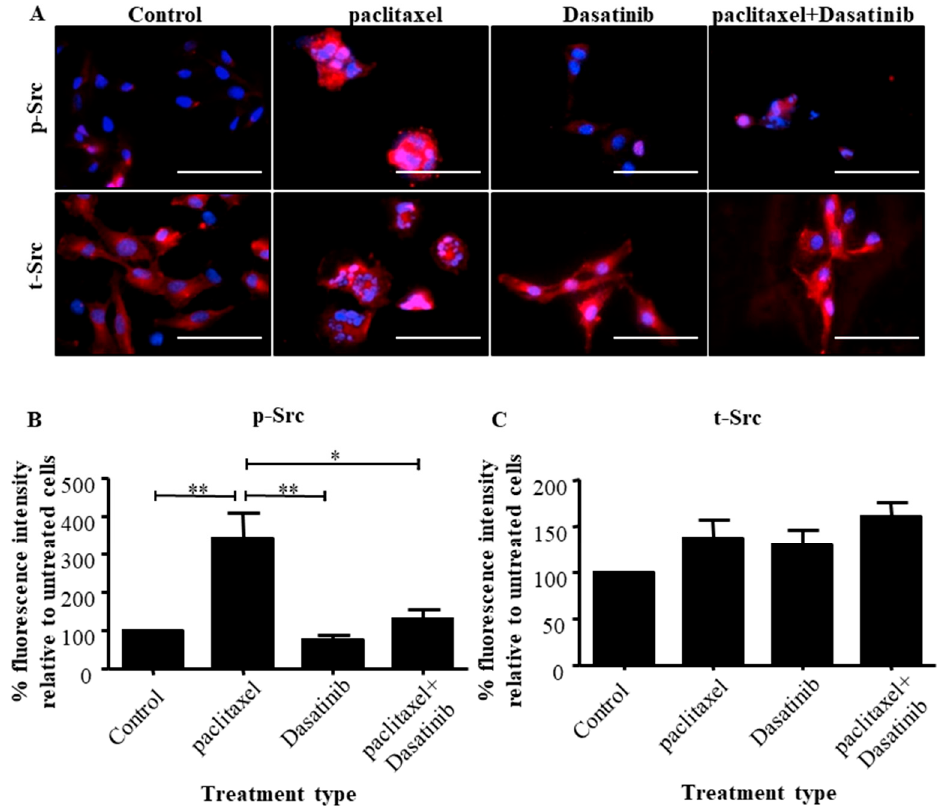
Figure 3. Dasatinib inhibits paclitaxel-induced Src activation in HEY cells. ( A ) Immunofluorescent visualization of expression and localization of the p- or t-Src proteins in untreated HEY cells or following a 24 h treatment with paclitaxel (0.05 µ g/mL), Dasatinib (10 µ M) or a combination of both. Staining was visualized using the secondary Alexa 590 (red) fluorescent-labelled antibodies and nuclei were detected by DAPI (blue) staining. Images are representative of three independent experiments. Magnification 400 × scale bar = 250 µ m. Quantification of ( B ) p-Src and ( C ) t-Src fluorescent intensities were determined using Fiji software. Results are expressed as the percentage of the average fluorescent intensity value relative to untreated cells ± SEM ( n = 3/group). Significance between the groups and is indicated by * p < 0.05, ** p < 0.01.